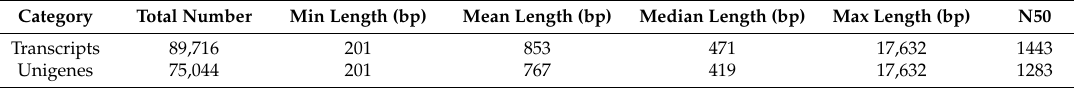
Figure 2. Distribution of transcript and unigene length in the assembled F. proliferatum reference transcriptome. Table 2. Sequence summary of transcriptome assembly statistics.